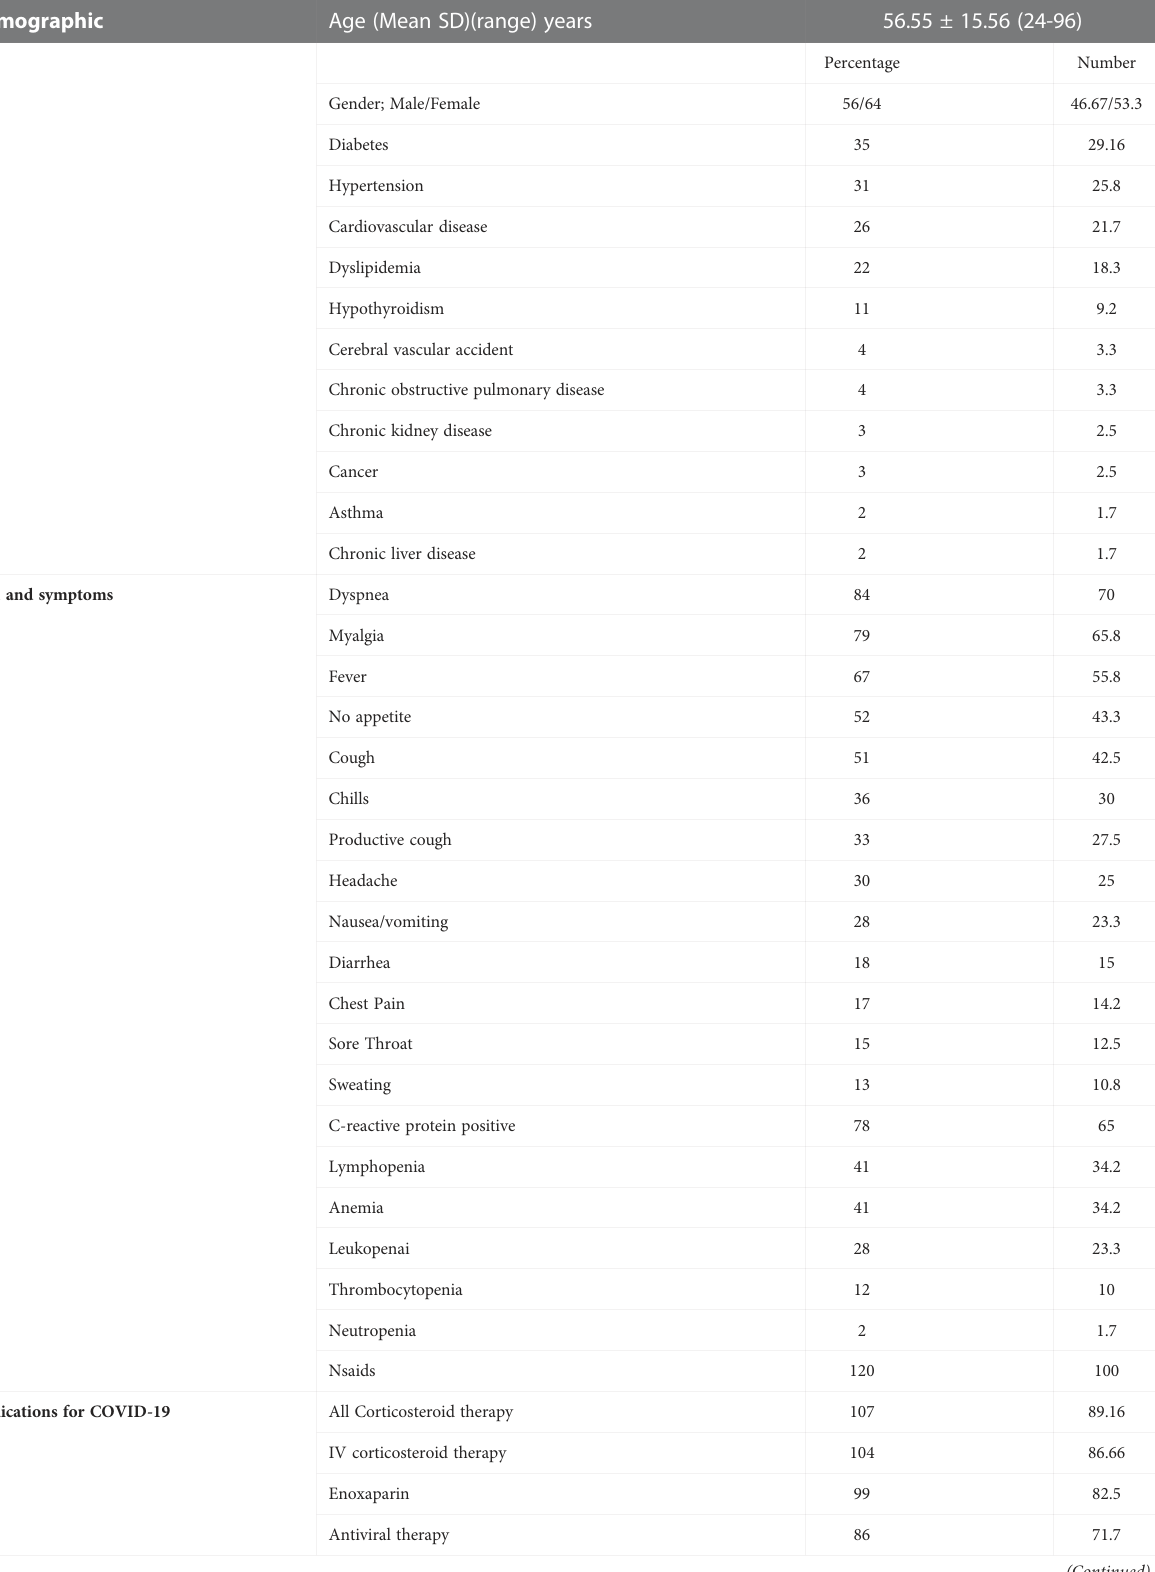
TABLE 1 Demographic Features, Comorbidities, Sign and Symptoms, Medication and Outcomes of COVID-19 Patients with Oral Candidiasis.